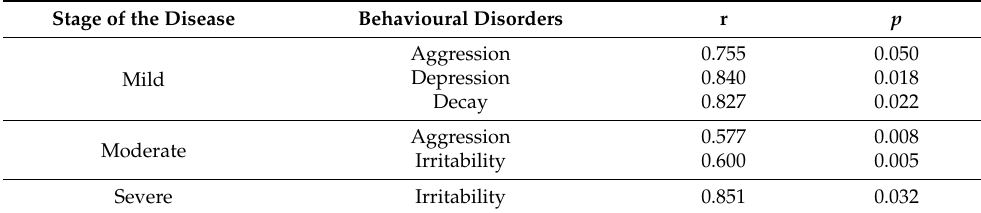
Table 9. Correlations between Burden, Behavioural Disorders and stage of disease.